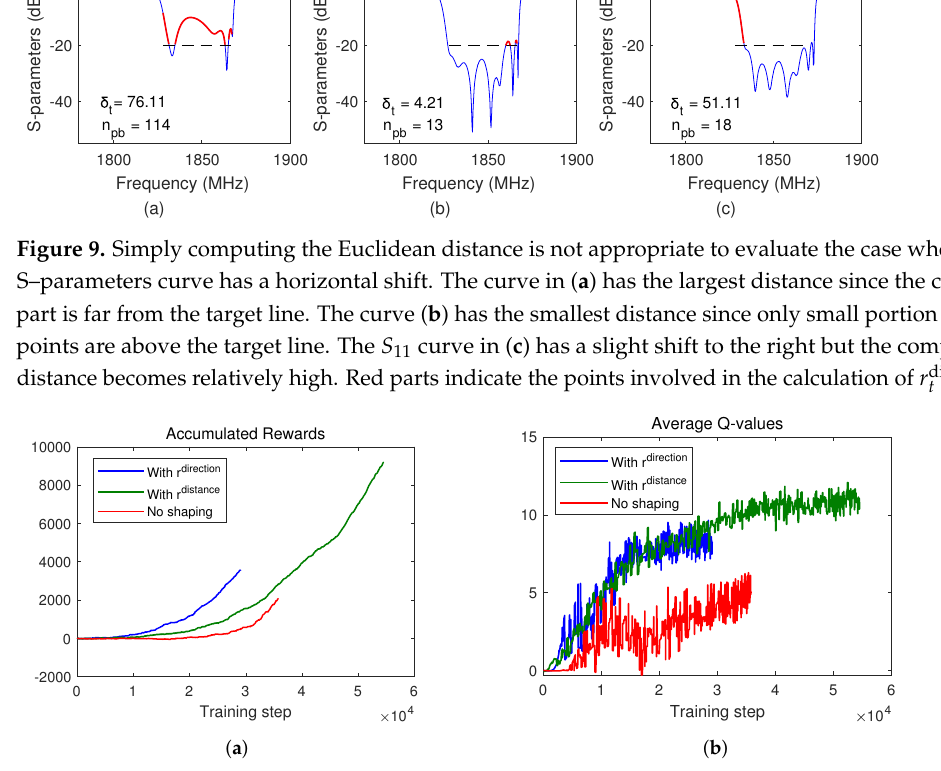
Figure 10. Analysis of the performance with learning curves: ( a ) Accumulated rewards during training episodes. ( b ) Q-values of the fixed set of states randomly initialized before training and evaluated after each training episode. Curves are recorded from one of the experiments for comparing the three reward functions but similar trends were observed from different experiments.